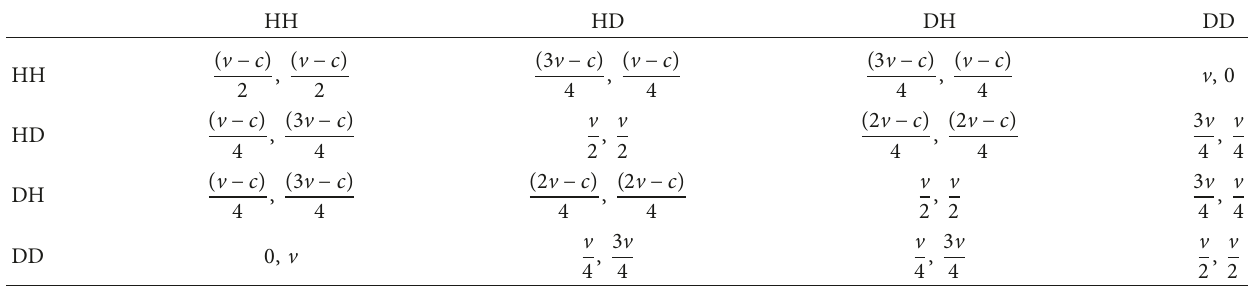
Table 1: The payoff matrix for the asymmetric Hawk-Dove